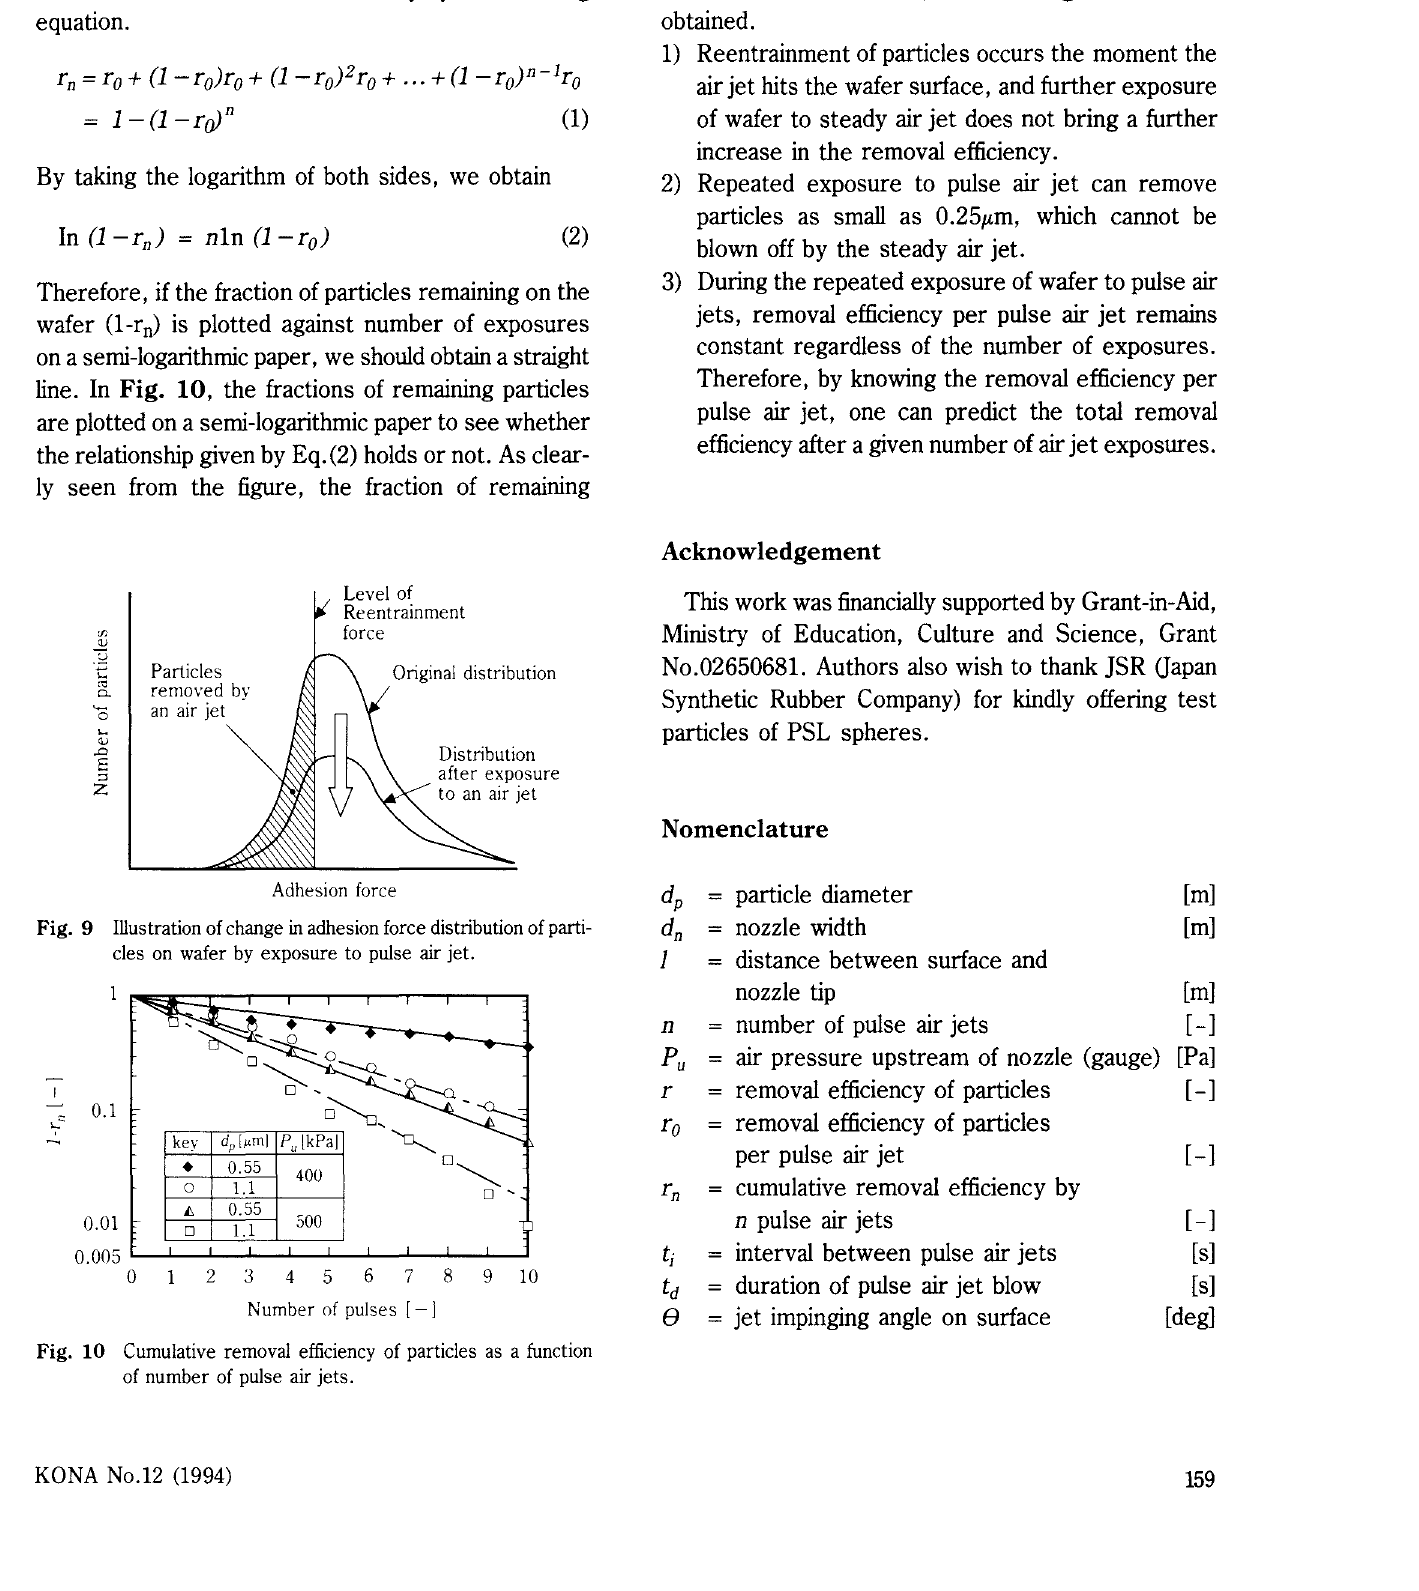
Fig. 9 Illustration of change in adhesion force distribution of parti cles on wafer by exposure to pulse air jet.